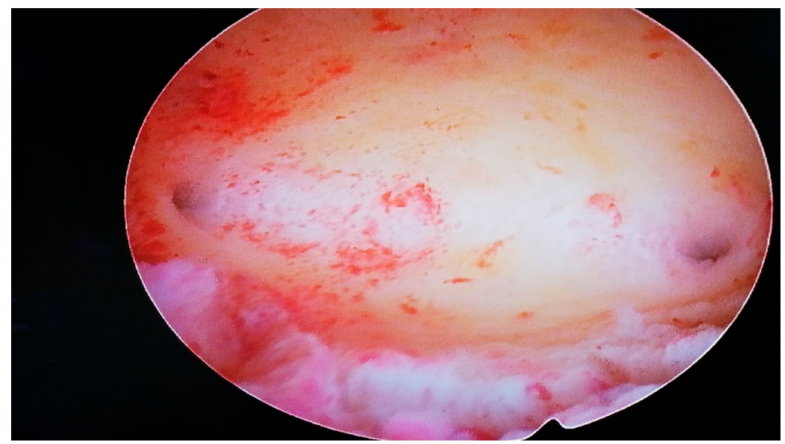
Figure 1. Mini-hysteroscopy view in the patient with Swyer